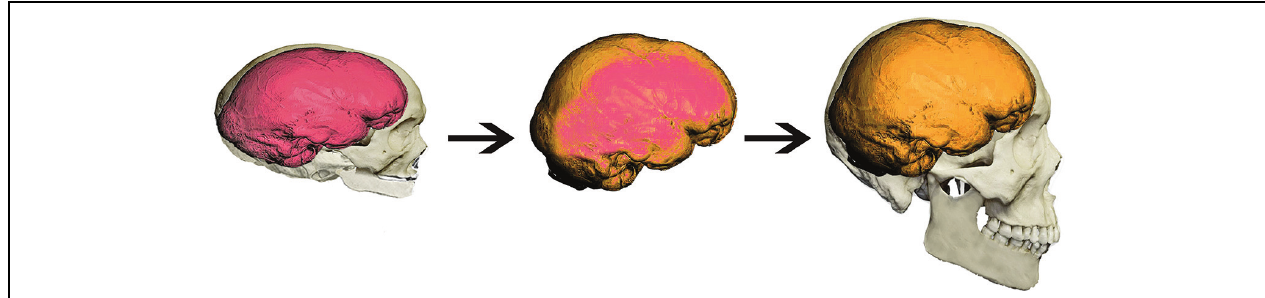
FIGURE 6 | Modern human newborns have elongated brain-skull shape. During the ‘Globularization Phase’ (in the middle) shape changes include a relative expansion of the cerebellum and parietal bulging. Modern human adults display finally a globular cranial and endocranial shape. (Mikaella Theofanopoulou; Rights